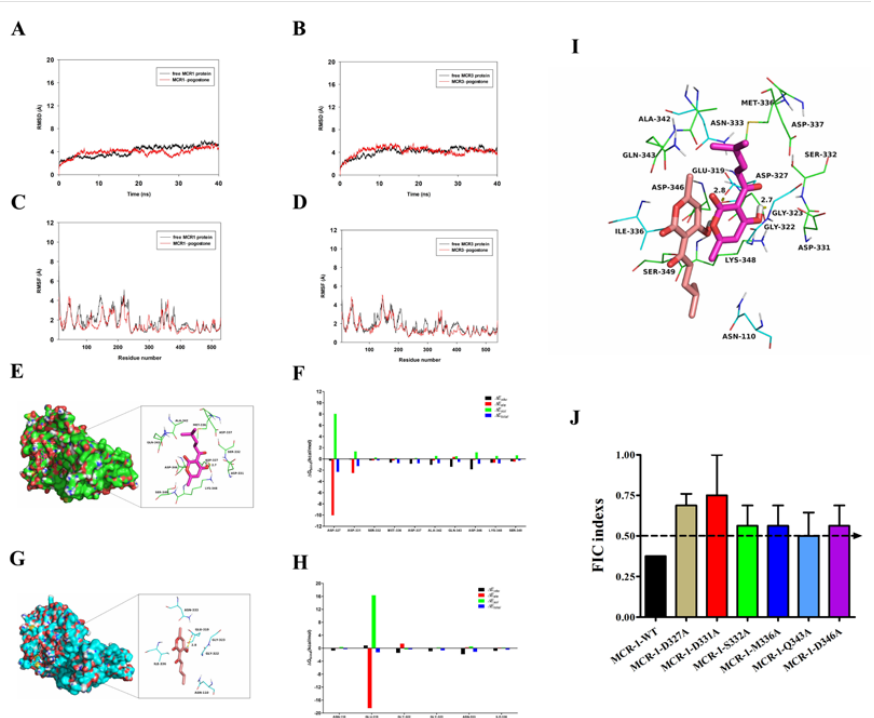
Figure 4. ( A , B ) The RMSDs of all the atoms of MCR-1/3-pogostone complexes with respect to the initial structure. ( C , D ) The RMSF of residues in the MCR-1/3-pogostone complex and free protein of MCR-1. ( E , G ) The 3D structures of MCR-1/3-pogostone complex by molecular modeling analysis. ( F , H ) The binding energy on a per-residue basis in the binding sites of MCR-1/3-pogostone complex. ( I ) Binding pattern diagram of MCR-1/3-pogostone complex (superposition). ( J ) The FIC indexes of pogostone with colistin of MCR-1-positive E. coli BL21 (DE3) (pET28a- mcr-1 ) and its MCR-1 mutants.